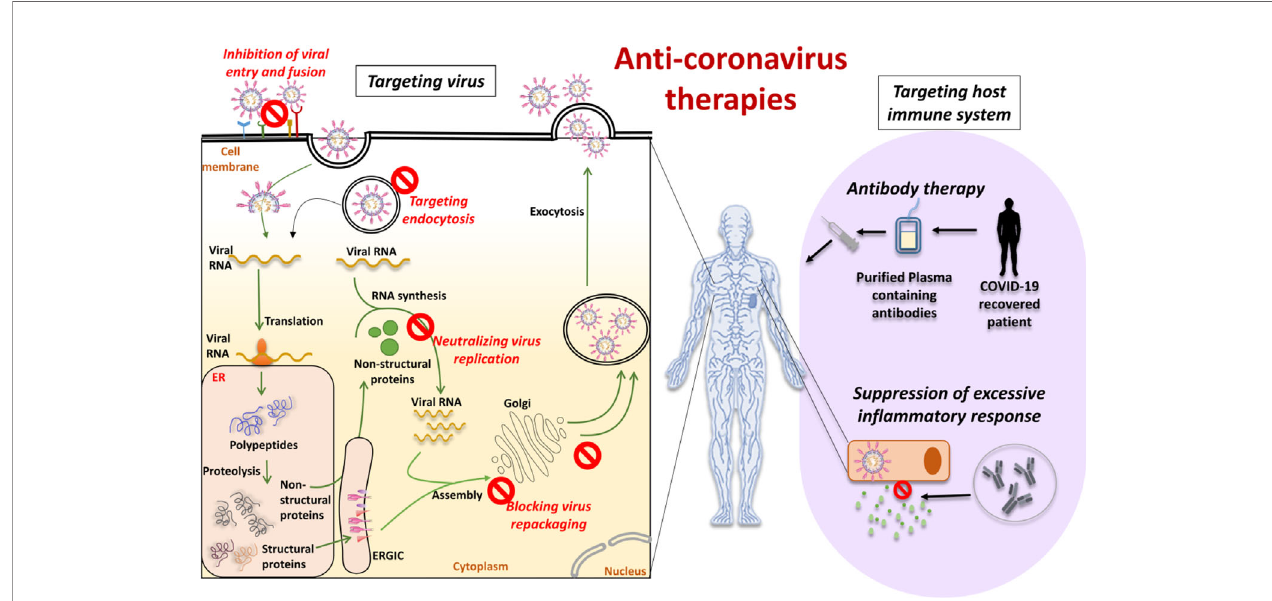
FIGURE 5 | Anti-coronavirus therapies can be based on targeting the virus or targeting the host immune system. Targeting the virus comprises inhibition of viral entry and fusion, targeting the endocytosis, neutralizing virus replication and blocking virus repackaging. Targeting host immune system comprises antibody therapy with plasma from recovered or convalescent patients and suppression of the excessive in fl ammatory